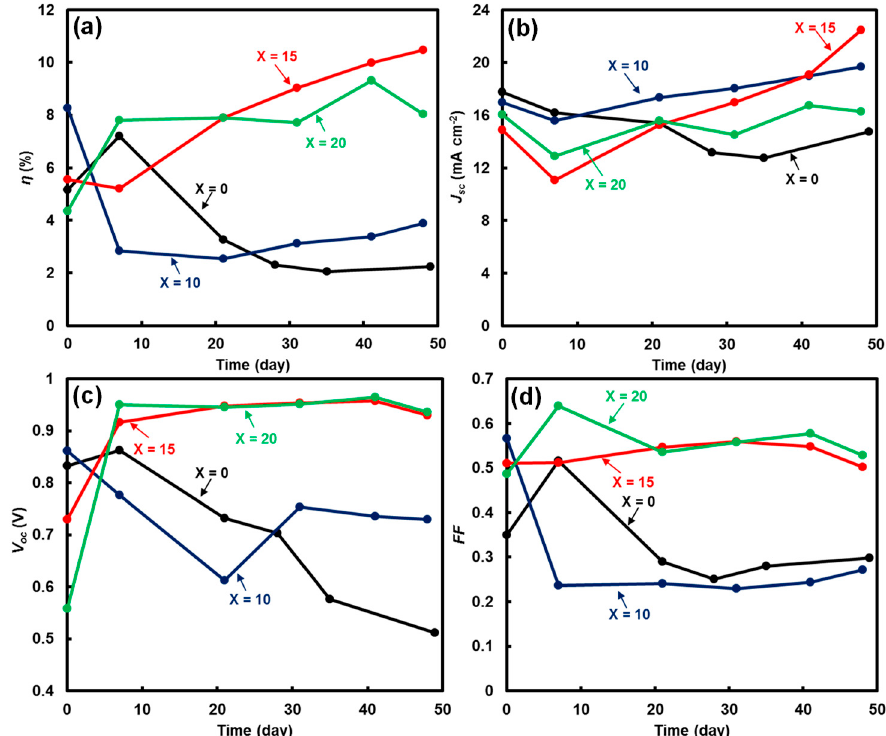
Figure 7. Stability measurements of the MAPbI 3 /(DPPS) ( X mg mL − 1 ) perovskite solar cells. ( a – d ) respectively, show photoelectric conversion efficiency ( η ), short circuit current density ( J sc ), open circuit voltage ( V oc ) and fill factor ( FF ).